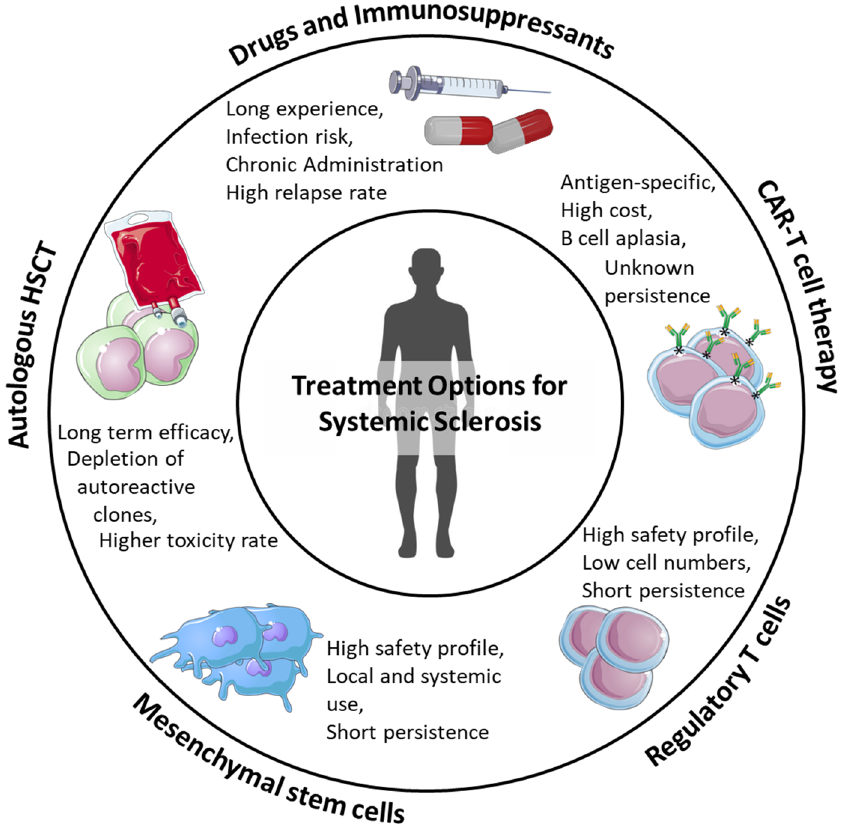
Figure 3. Advantages and limitations of different types of available or potential treatment options for SSc. for